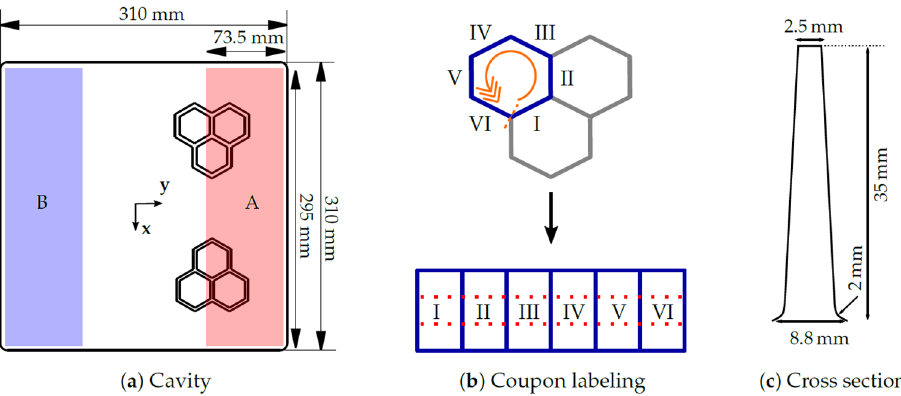
Figure 1. Geometry and specimen labeling. ( a ) The thick honeycomb is located at the top, and the thin honeycomb is located at the bottom in this representation. The shaded areas show where the initial SMC charge is placed. The red area indicates the charge position in Configuration A, whereas the blue area shows the charge position in Configuration B. ( b ) The coupon (blue) of the thick honeycomb is mentally unrolled anti-clockwise. This arrangement is used for the presentation of µCT scans, thermal gravimetric analysis (TGA) results and predictions of process simulations. The red dotted lines indicate the positions where the walls are cut into smaller specimens for TGA. ( c ) Cross section of walls that form the thick